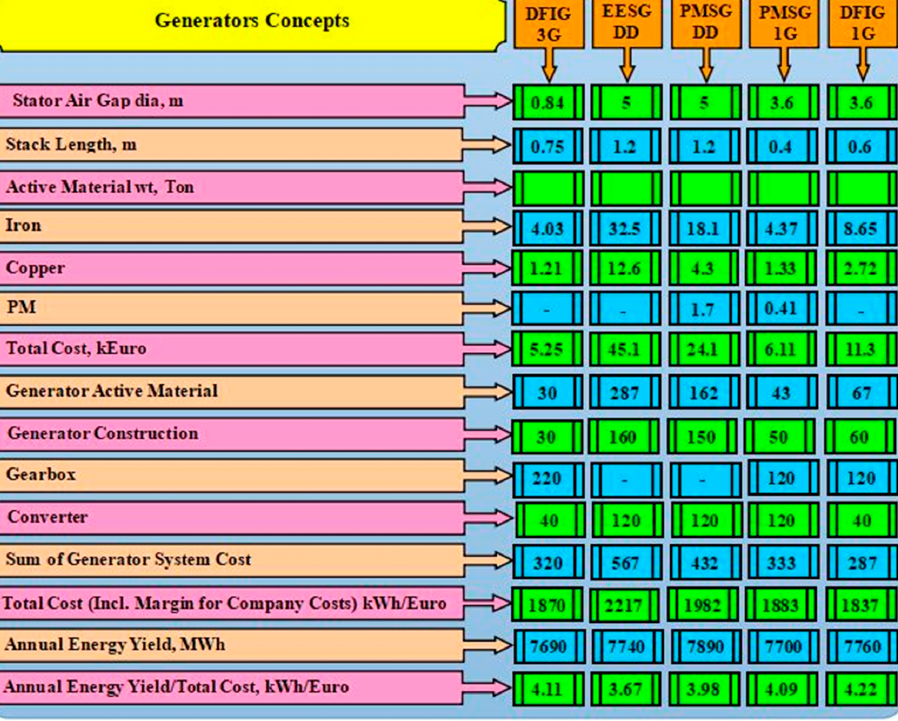
Figure 9. Comparison of five different wind generator systems [31].